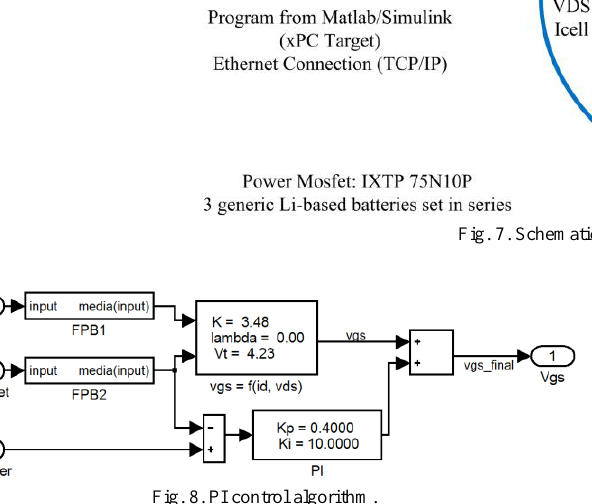
Fig. 8. PI control